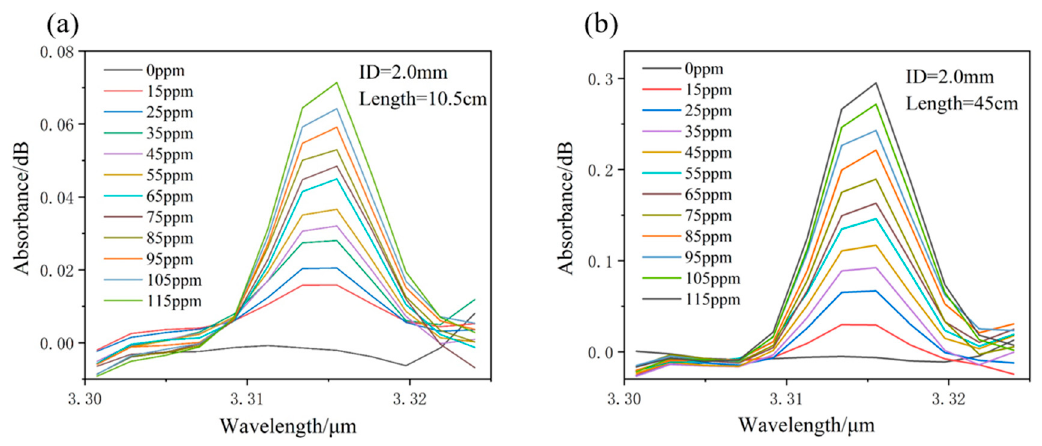
Figure 7. Absorption peaks for methane gases of different concentrations. ( a ) eHWG-1; ( b ) eHWG-4 with AgI/Ag waveguides.